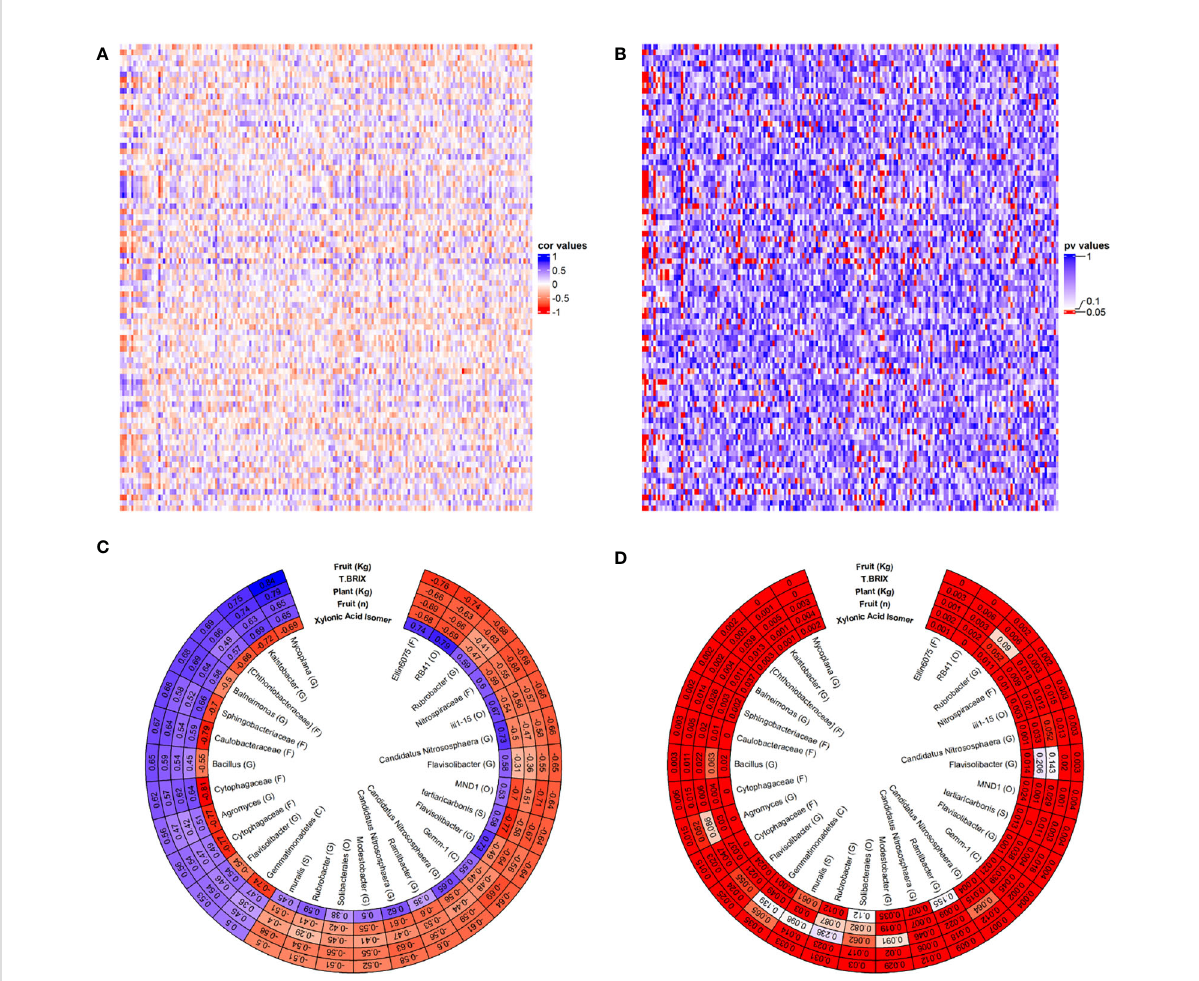
FIGURE 5 Correlations between the microbiome and between physiological and metabolomic measurements. OTU count data were normalized using Variance Stabilizing Transformation and OTUs with missing data (NAs) were fi ltered out. (A, B) Each OTU was correlated (Spearman) with each physiological measurement and metabolite and correlation values (A) and p-values (B) are presented. (C, D) The most highly correlated OTUs and metabolomic and physiological measurements were manually sifted and the correlation values (C) and p-values (D) are